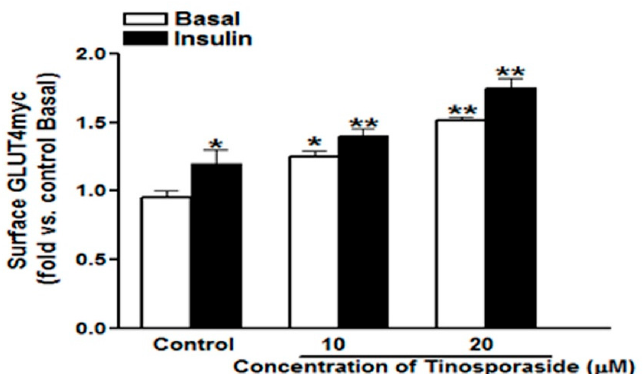
Figure 3. Dose-dependent effect of tinosporaside on GLUT4 myc translocation in L6-GLUT4 myc my- otubes. Cells were incubated with 10 μ M and 20 μ M concentrations of tinosporaside for 16 h, with the final three hours in a serum-deprived medium. After incubation, myotubes were left untreated (white bars) or stimulated with 100 nM insulin (black bars) for 20 min, which was followed by the determination of the proportion of GLUT4 myc at the cell surface. Results are expressed as fold stim- ulation over control basal. Results shown are mean ± SE of three independent experiments, each performed in triplicate. * p < 0.05, ** p < 0.01, relative to respective control condition. To investigate the mechanism by which tinosporaside augmented glucose uptake in L6 myotubes, first we assessed its response in presence of wortmannin, a specific inhibitor of the PI3K. The presence of wortmannin (100 nM) completely reversed the insulin- induced glucose uptake to basal level. Similarly, tinosporaside-induced glucose uptake was inhibited in the presence of wortmannin in L6 myotubes (Figure 4). Tinosporaside- mediated potentiation of insulin response to increase glucose uptake was also completely abolished to the basal level in the presence of wortmannin (Figure 4). These results indicate that tinosporaside stimulates glucose uptake in L6 myotubes in part via the PI3K signaling pathway.